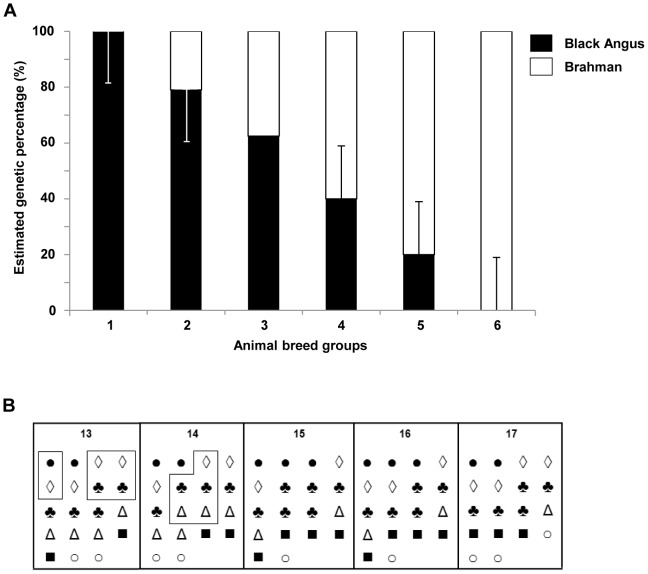
Estimated genetic backgrounds of animals used and housing in five pens.(A) Cattle consisted of six Angus-Brahman multibred groups. Group 1 = 100% to 80% Angus, 0% to 20% Brahman; Group 2 = 79% to 60% Angus, 21% to 40% Brahman; Group 3 = 62.5% Angus, 37.5% Brahman, Group 4 = 59% to 40% Angus, 41% to 60% Brahman, Group 5 = 39% to 20% Angus, 61% to 80% Brahman, Group 6∶19% to 0% Angus, 81% to 100% Brahman. Bars indicate the expected portion of Angus and Brahman genetic traits in each breed group. (B) Animals were systemically housed in five pens according to their genetic background and sex. • is Calf breed group 1, ◊ is Calf breed group 2, ♣ is Calf breed group 3, Δ is Calf breed group 4, ▪ is Calf breed group 5, and ○ is Calf breed group 6. Bulls in pen 13 and 14 are boxed.